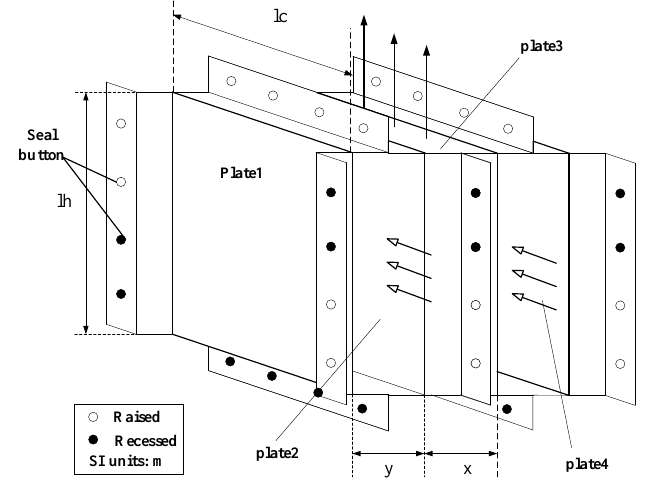
Figure 8. Schematic diagram of the sealed channel structure.